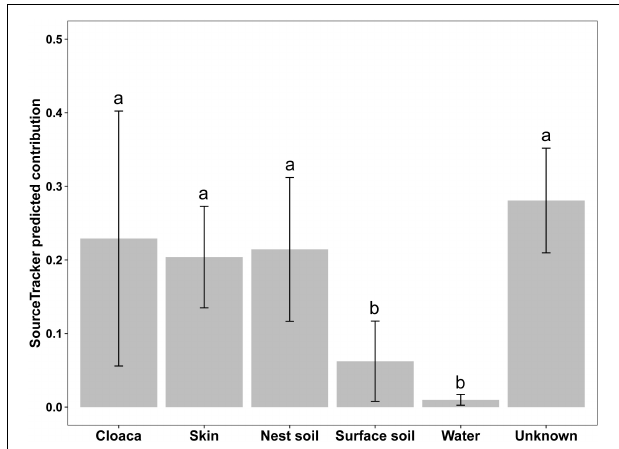
FIGURE 6 | Predicted contributions of maternal and environmental sources to eggshell bacterial communities. Different lowercase letters indicate a statistically significant difference (Dunn’s test, FDR-corrected P < 0.05). Data are expressed as mean ± 95%